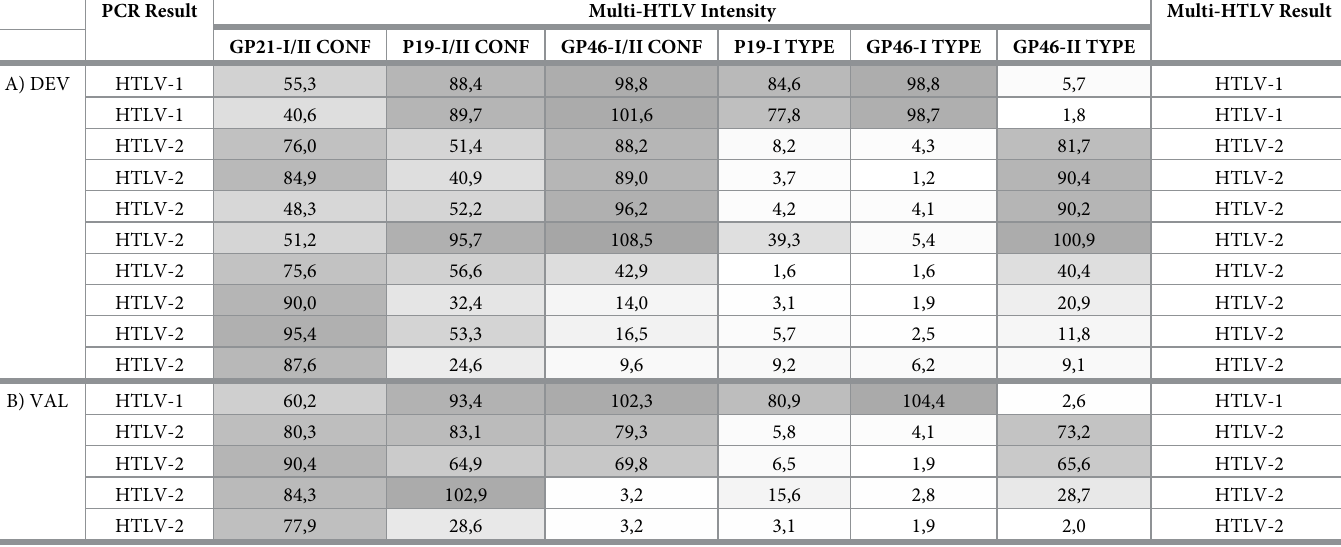
Table 6. Multi-HTLV results for HTLV/HCV co-infected